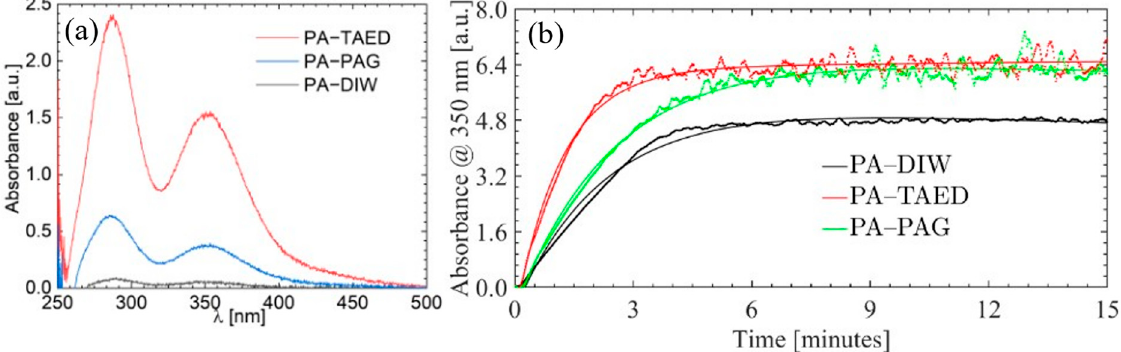
Figure 9. Oxidation of KI by PA-DIW, PA-TAED and PA-PAG as measured by UV-vis spectroscopy. Typical UV-vis profiles are shown in ( a ) indicating the peak for the triiodide ion at 350 nm used to ( b ) track the temporal changes in KI oxidation.